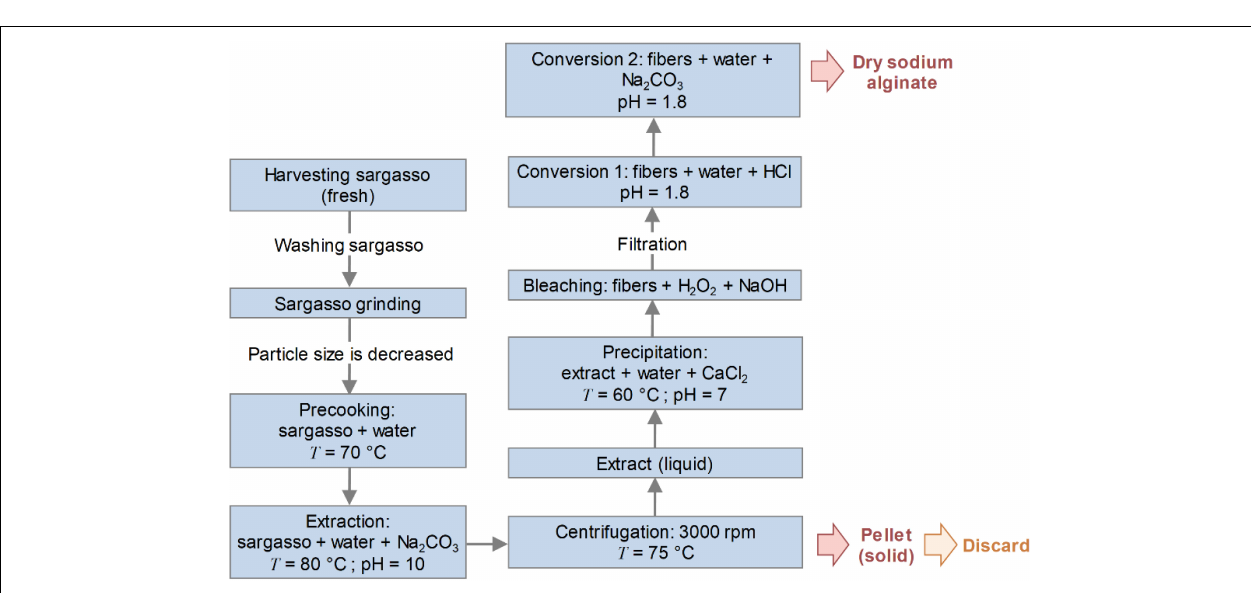
FIGURE 4 | Barriers contain the sargasso (A) and it is collected at sea (B) . Photos courtesy of Grupo Dakatso S.A. de C.V.